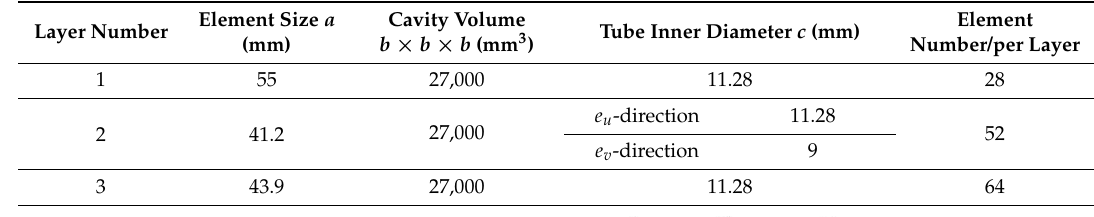
Table 1. Design parameters of block elements used in the cloak shell.